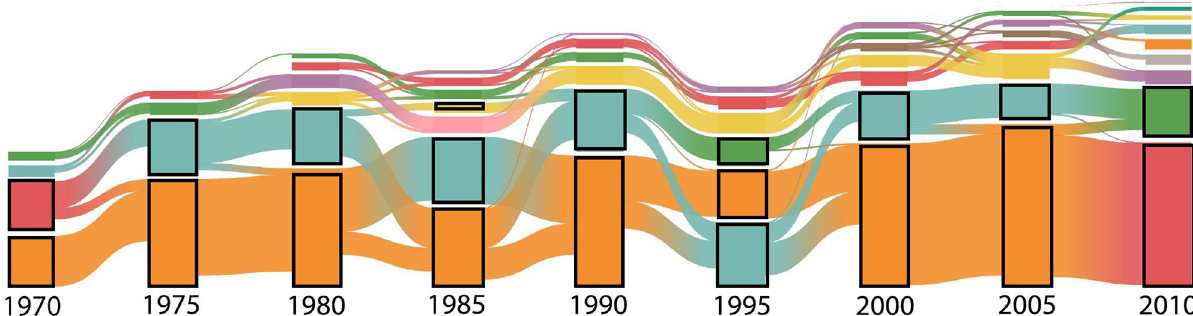
Fig 5. The alluvial diagram of stable blocks. The diagram shows the change of memberships of the stable blocks from 1970 to 2010 every 5 years (from left to right). The flow from block b 1 in year t to block b 2 in year t + 5 represents a situation in which actors who had belonged to b 1 in year t belonged to b 2 in year t + 5. The height of each block indicates the number of nodes (actors) in the block. Colors are used to make blocks distinguishable and do not represent any block characteristics. The blocks surrounded by black lines are the recipient